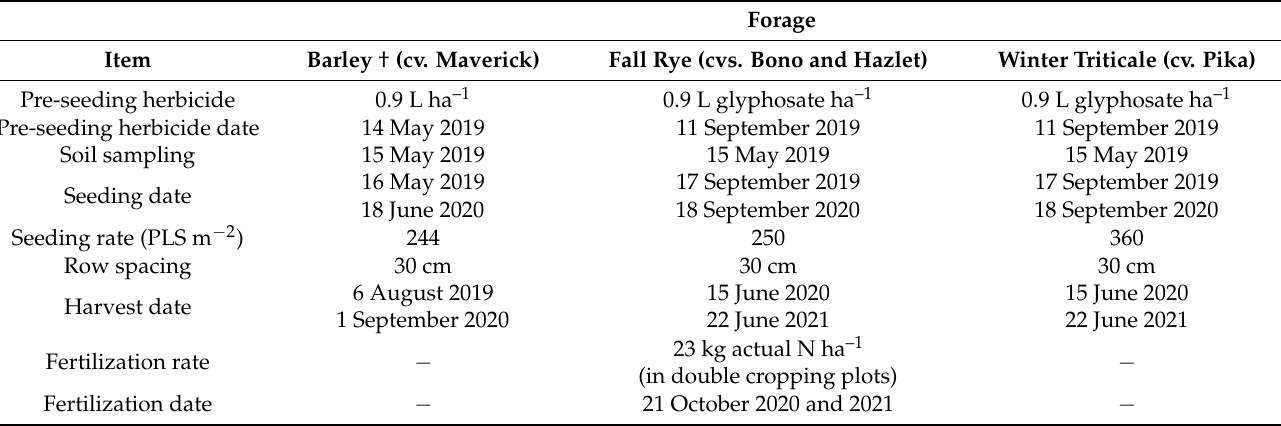
Table 1. Agronomic information of winter cereal in single cropping system and barley in double cropping system with fall rye over 3 years (2019 to 2021).